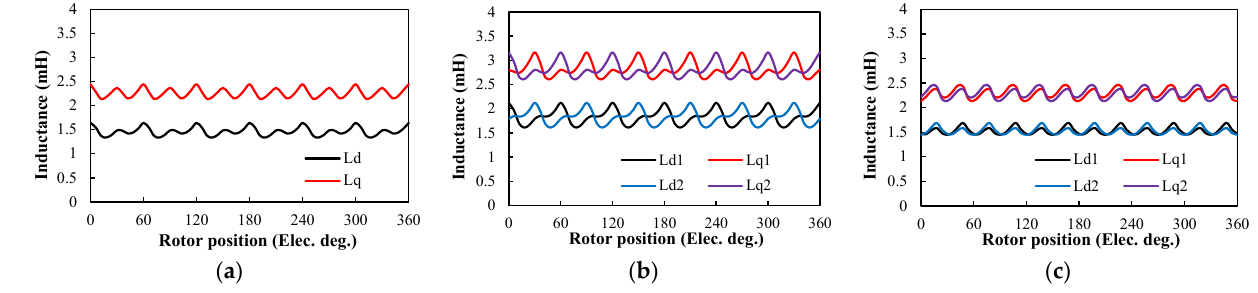
Figure 25. d- and q-axis inductances of different winding configurations at maximum torque condition: ( a ) ORG; ( b ) DTP-SF; ( c ) DTP-DS.